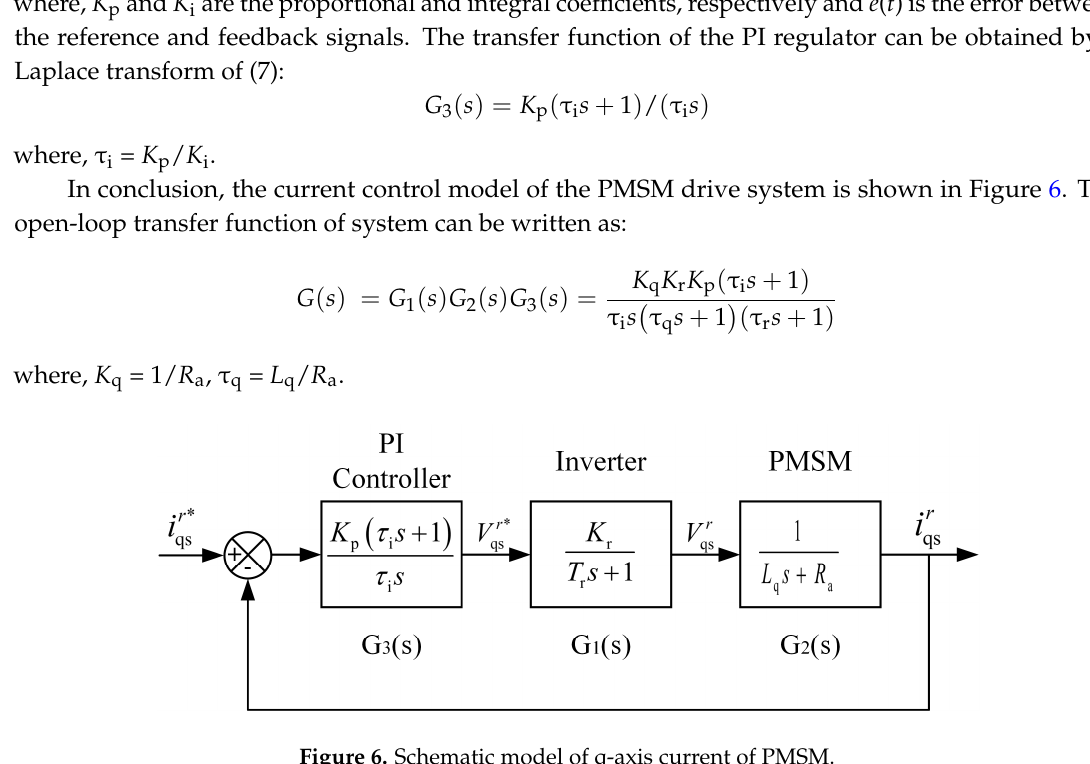
Figure 6. Schematic model of q-axis current of PMSM.